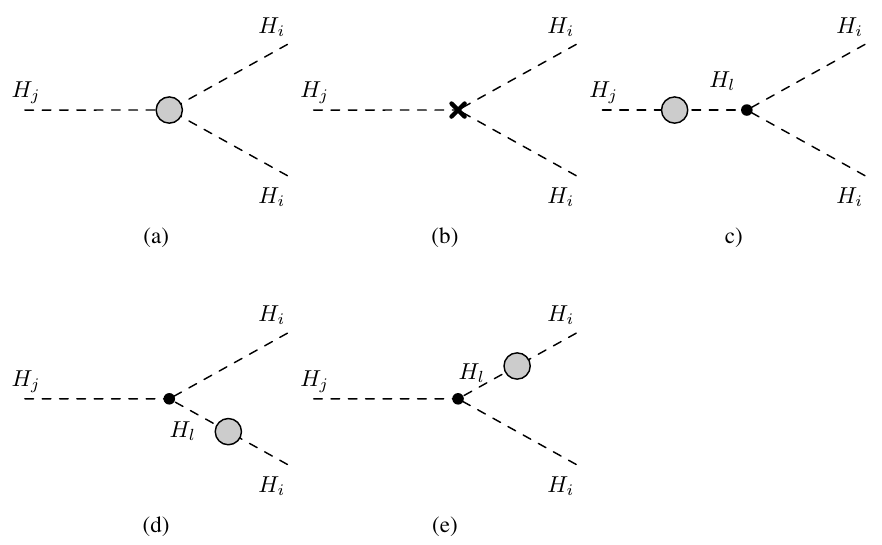
Figure 10 . Generic diagrams contributing to the virtual corrections of the decay H j ! H i H i : vertex corrections (a) and corrections to the external legs (c)-(e). Diagram (b) displays the corre- sponding vertex